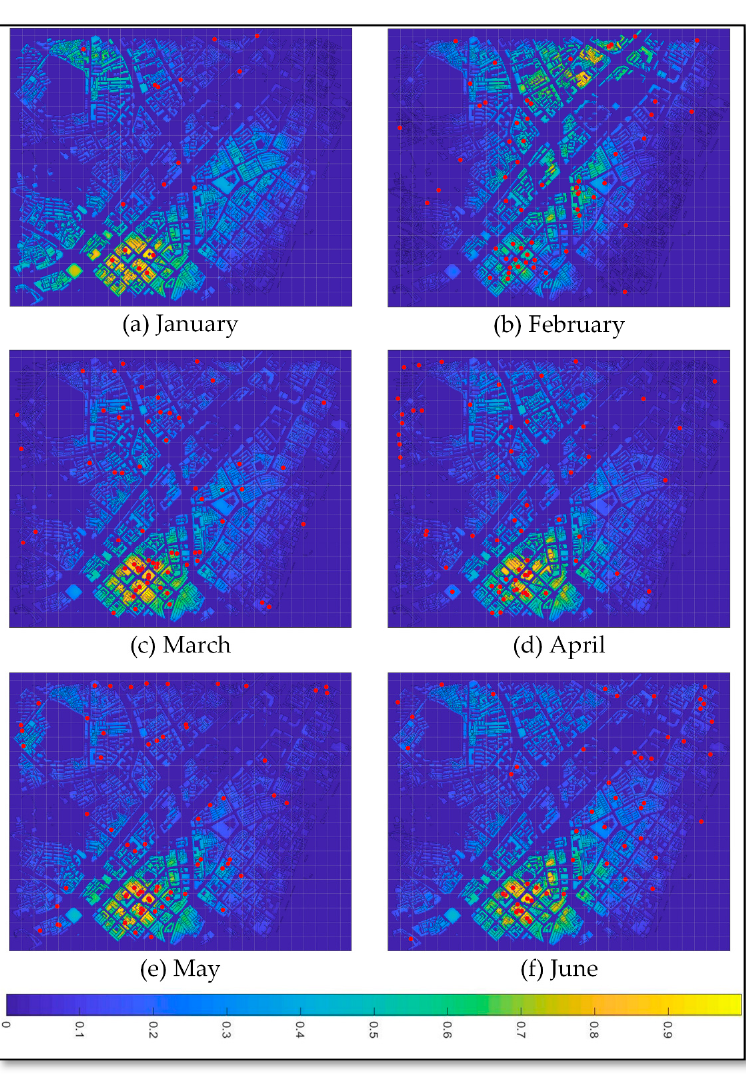
ff ectiveness of AnisDM for crime prediction over time. Figure 11. Effectiveness of AnisDM for crime prediction over time. Figure 11. E